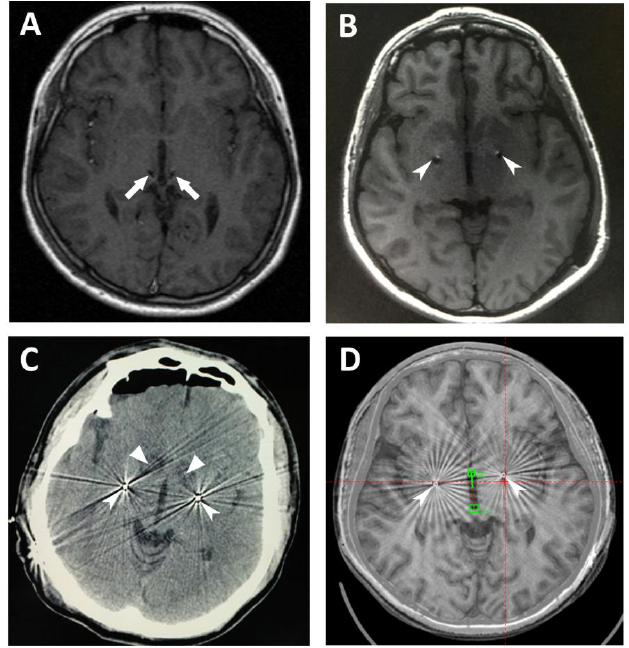
Figure 1. Location of the leads and lesions on postoperative MRIs and CTs. ( A ) Case 6, magnetic resonance imaging (MRI) scan of the brain after lead implantation, demonstrating the bilateral leads in the centromedian – parafascicular complex (CM-Pf); ( B ) Case 7, brain MRI scan after lead implantation, showing the bilateral leads in the globus pallidus internus (GPi); ( C ) Case 8, computed tomography (CT) scan of the brain after ablation and lead implantation, demonstrating the bilateral lesions in the anterior limb of the internal capsule (ALIC) and the bilateral leads in the GPi; ( D ) Case 13, fusion of the postoperative CT with preoperative MRI, demonstrating the bilateral leads in the GPi. The arrows denote CM-Pf, the arrowheads denote GPi, and the triangles denote ALIC.